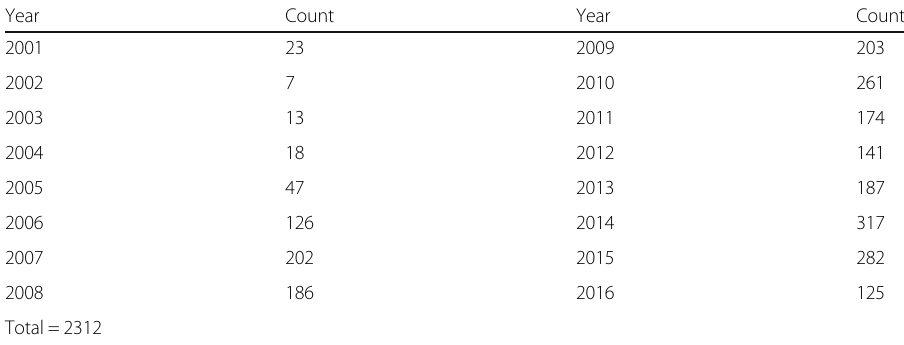
Table 1 Per year distribution of the collected dissertations